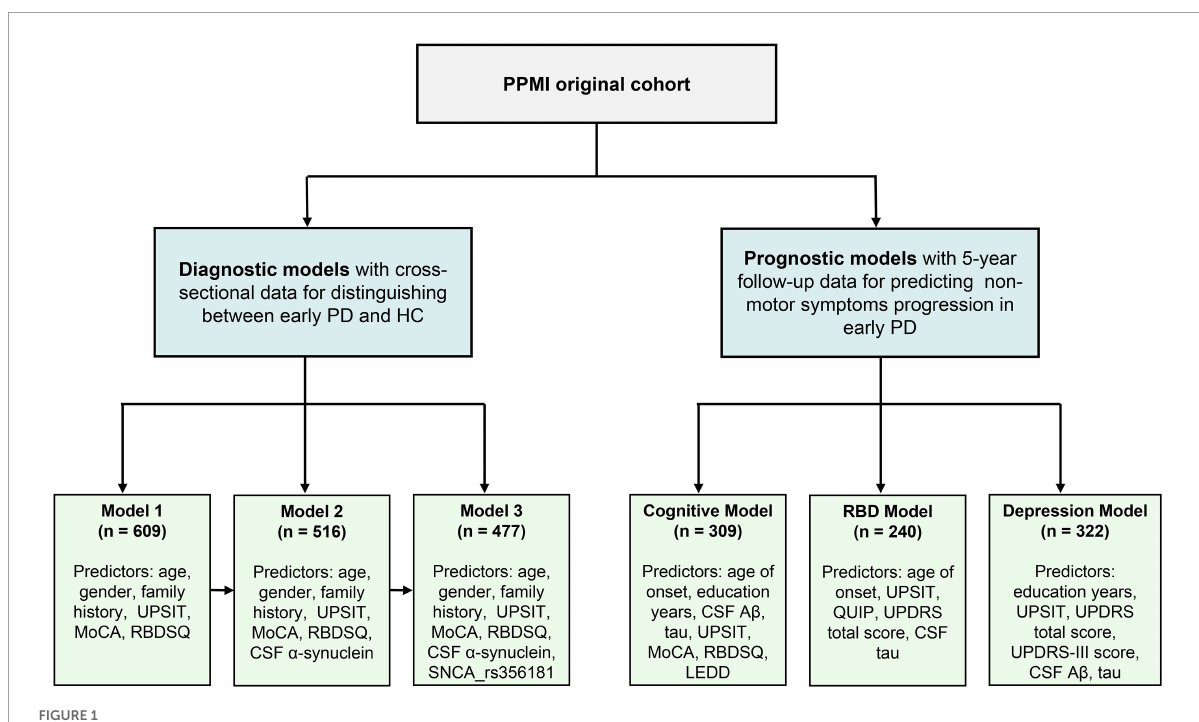
FIGURE1 Flowchart of data analysis. PPMI, Parkinson’s Progression Markers Initiative; PD, Parkinson’s disease; MoCA, Montreal Cognitive Assessment; UPSIT, University of Pennsylvania Smell Inventory Test; RBM, Rapid-eye-movement sleep Behavior Disorder Screening Questionnaire; MDS-UPDRS, Movement Disorder Society-Sponsored Revision of the Unified Parkinson’s Disease Rating Scale; CSF, cerebrospinal fluid; A β , amyloid- β